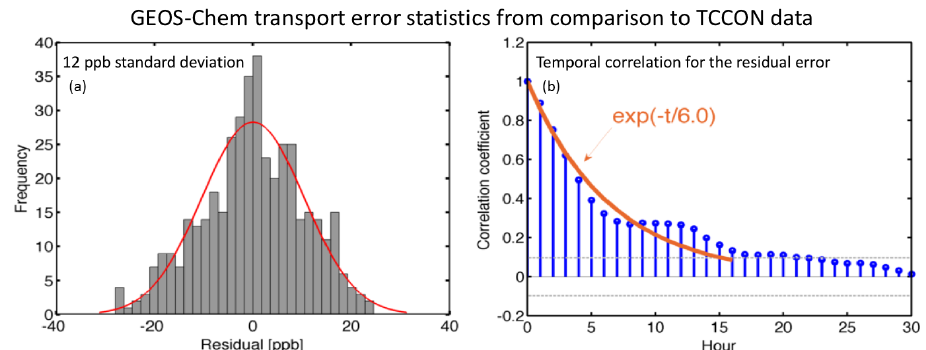
Figure 3. GEOS-Chem model transport error statistics derived from the residual error method (Heald et al., 2004) applied to hourly TCCON ground-based observations in Lamont, Oklahoma, in August–September 2013. Residuals are the differences between hourly simulated and observed values after removal of the mean bias. Panel (a) shows the frequency distribution of residual error (GEOS-Chem minus TCCON) and a Gaussian fit to that distribution with standard deviation 12ppb. Panel (b) shows autocorrelation coefficients of the residual error plotted against time lag and an exponential fit with a temporal error correlation e -folding scale of 6h. Significance levels ( p < 0 . 05) are shown as dashed lines. The correlation becomes insignificant past a time lag of 16h.